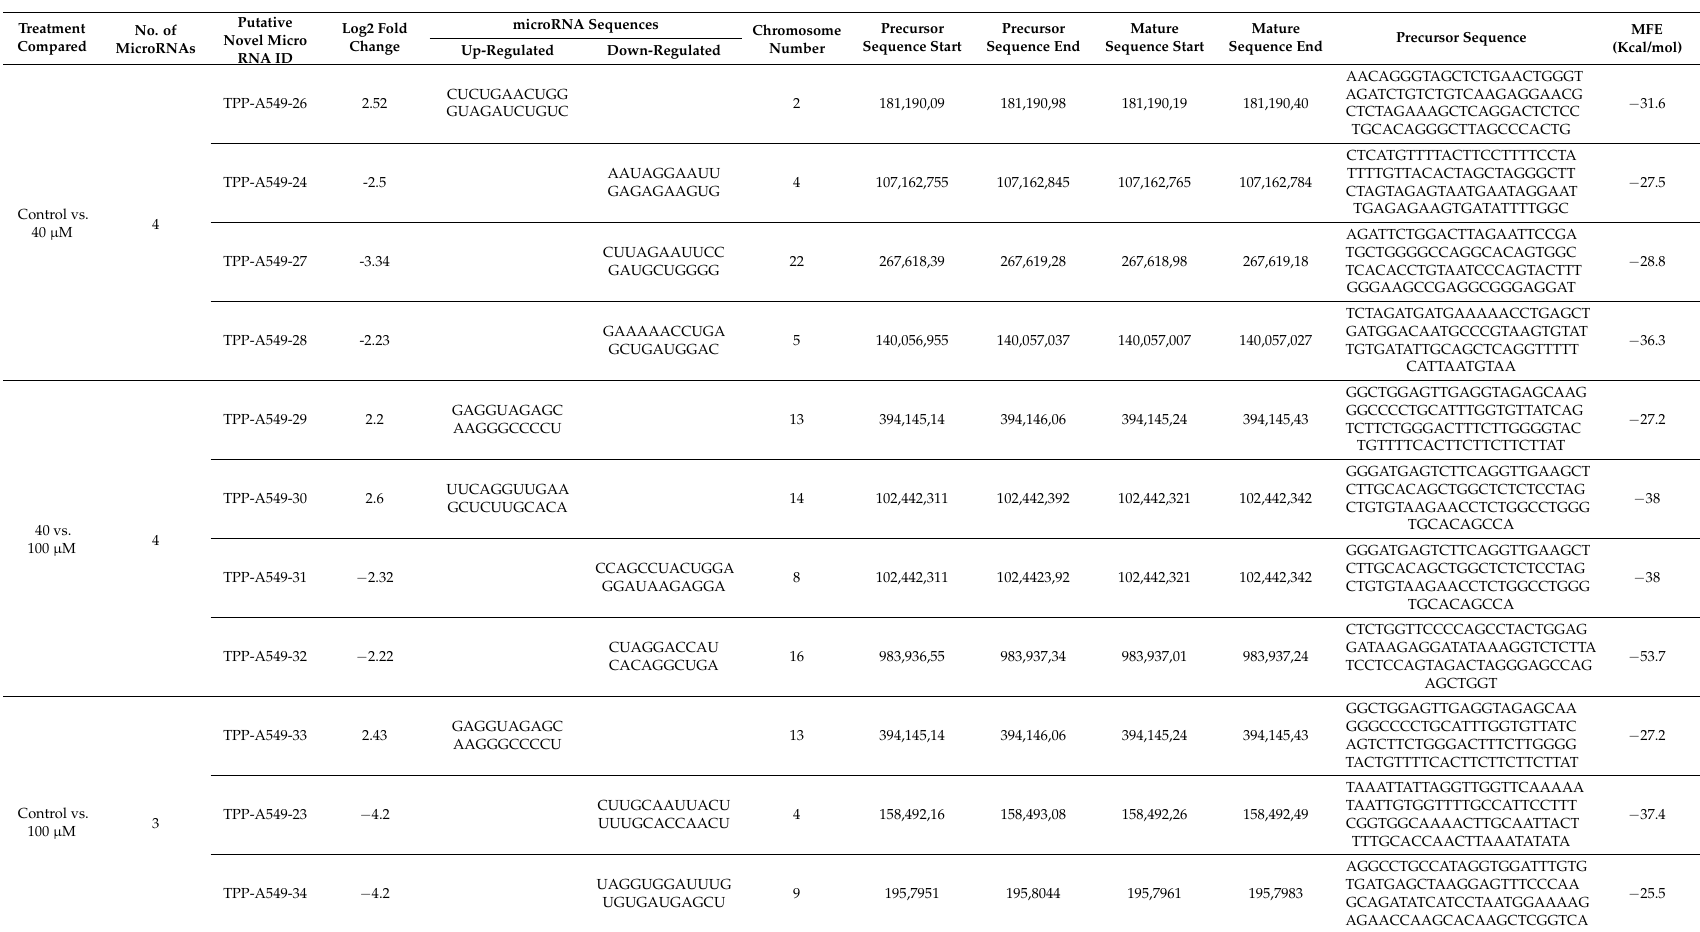
Table 3. Putative novel microRNA sequences with greater than 2 log2 fold change in expression after 40 and 100 µ M EGCG treatments. Treatment